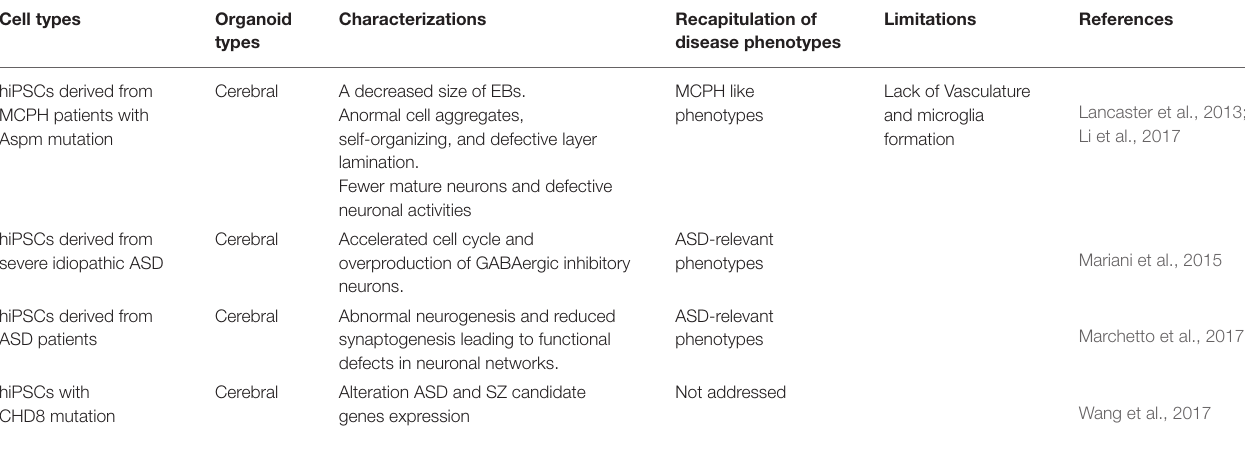
TABLE 5 | Modeling neurodevelopmental disorders in hiPSC-derived